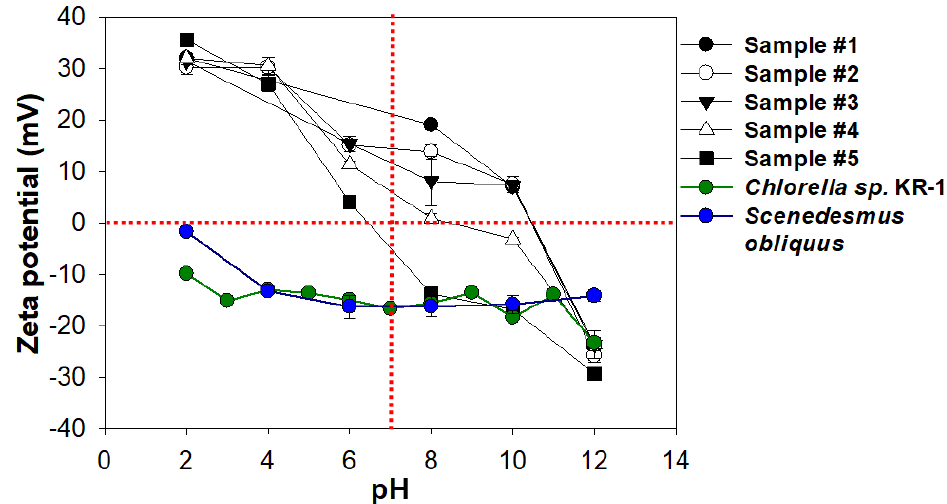
Figure 4. Zeta potentials of samples #1–5, Chlorella sp. KR-1 and Scenedesmus obliquus according to pH.